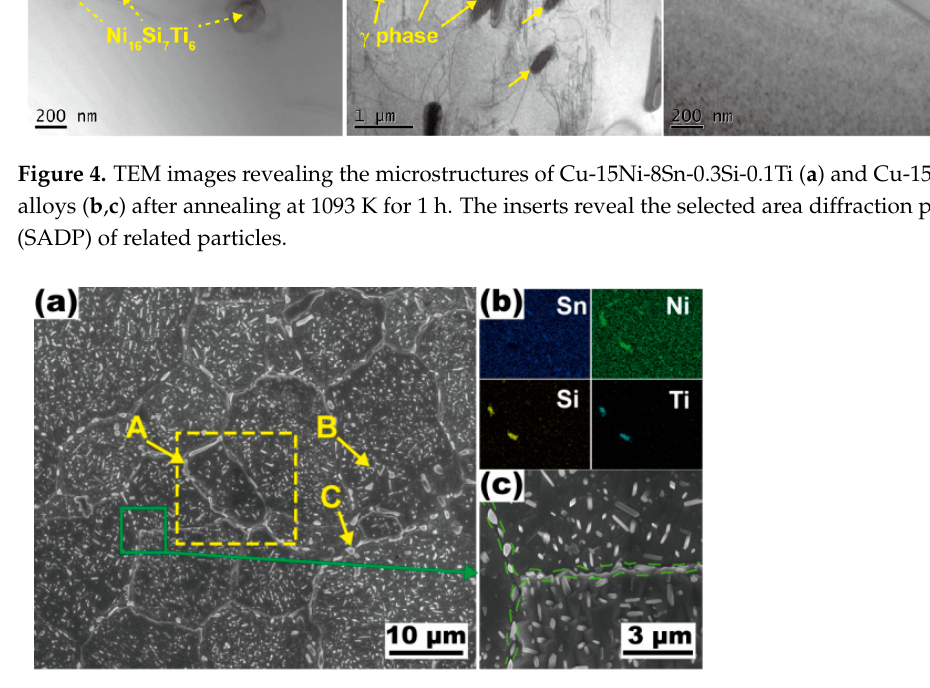
Figure 5. SEM micrographs of the Cu-15Ni-8Sn-0.3Si-0.1Ti alloy after annealing at 1093 K for 5 min. ( a ) Grain morphology in the alloy; ( b ) the EDS-mapping result corresponding to the yellow rectangle in ( a ); ( c ) enlarged view of the green domain in ( a ), small needle-like particles distributed along the grain boundaries are marked by the green dotted line. Table 3. EDS results of corresponding positions in Figure 5 (wt.%). Figure 6 indicates the microstructural features of the modified alloy after solution processing at 1093 K for 1 h. A large amount of the Ni 16 Si 7 Ti 6 and γ phases can still be observed in the alloy. Figure 6b shows micron particles are distributed around the grains, which implies the inhibiting effect of grain growth induced by these insoluble particles.